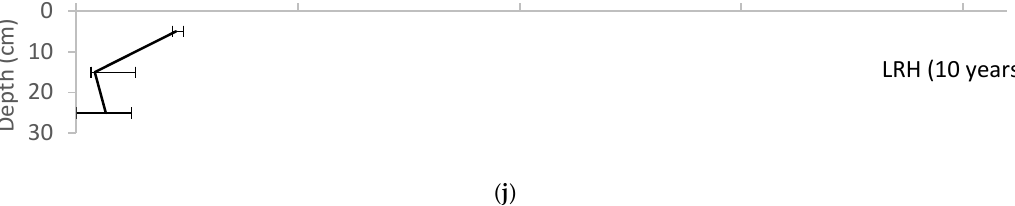
Figure 6. Variation of earthworm density with depth for each of the field sites, reported as median ± range. ( a ) UMCP; ( b )WNY; ( c ) MJES; ( d ) CBF; ( e ) NWHS; ( f ) PP; ( g ) CF; ( h ) CC; ( i ) BP; ( j ) LRH. The absolute values of macroinvertebrate density and diversity varied greatly across sites, with the highest values found in the surface layers and declining values with depth (Figure 7). Earthworms (Oligochaeta, family Lumbricidae) were the most abundant macroinvertebrate group represented along with ants (Hymenoptera, family Formicidae) and adult beetles (Coleoptera). Other groups found in the pits included: beetle larvae (Coleoptera, family Scarabaeidae), centipedes (Chilopoda), millipedes (Diplopoda), pill bugs (Isopoda), pot worms (Enchytraeidae), spiders (Araneae), springtails (Collembola), slugs and snails (Gastropoda), fly larvae (Diptera), and mites (Acari), as shown in Table 3. Detailed data for all soil parameters at the sites are given in Ayers [38].